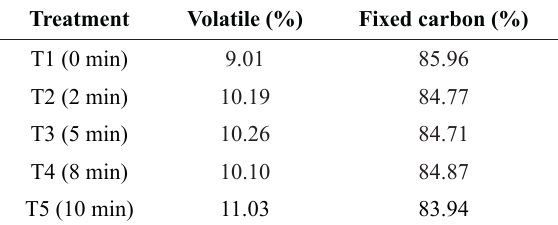
Immediate analysis of each